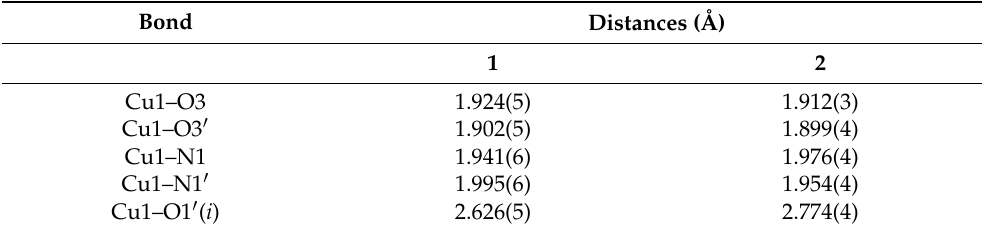
Table 3. Selected bond lengths for complexes 1 and 2